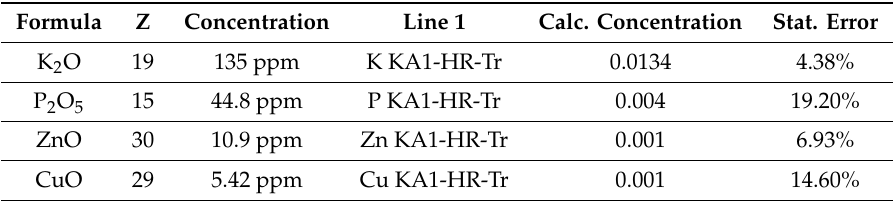
Table 3. Concentrations of di ff erent inorganic compounds found in SEEP determined by Wavelength Dispersive X-Ray Fluorescence. Formula Z Concentration Line 1 Calc. Concentration Stat. Error K 2 O 19 135 ppm K KA1-HR-Tr 0.0134 4.38% P 2 O 5 15 44.8 ppm P KA1-HR-Tr 0.004 19.20% 10.9